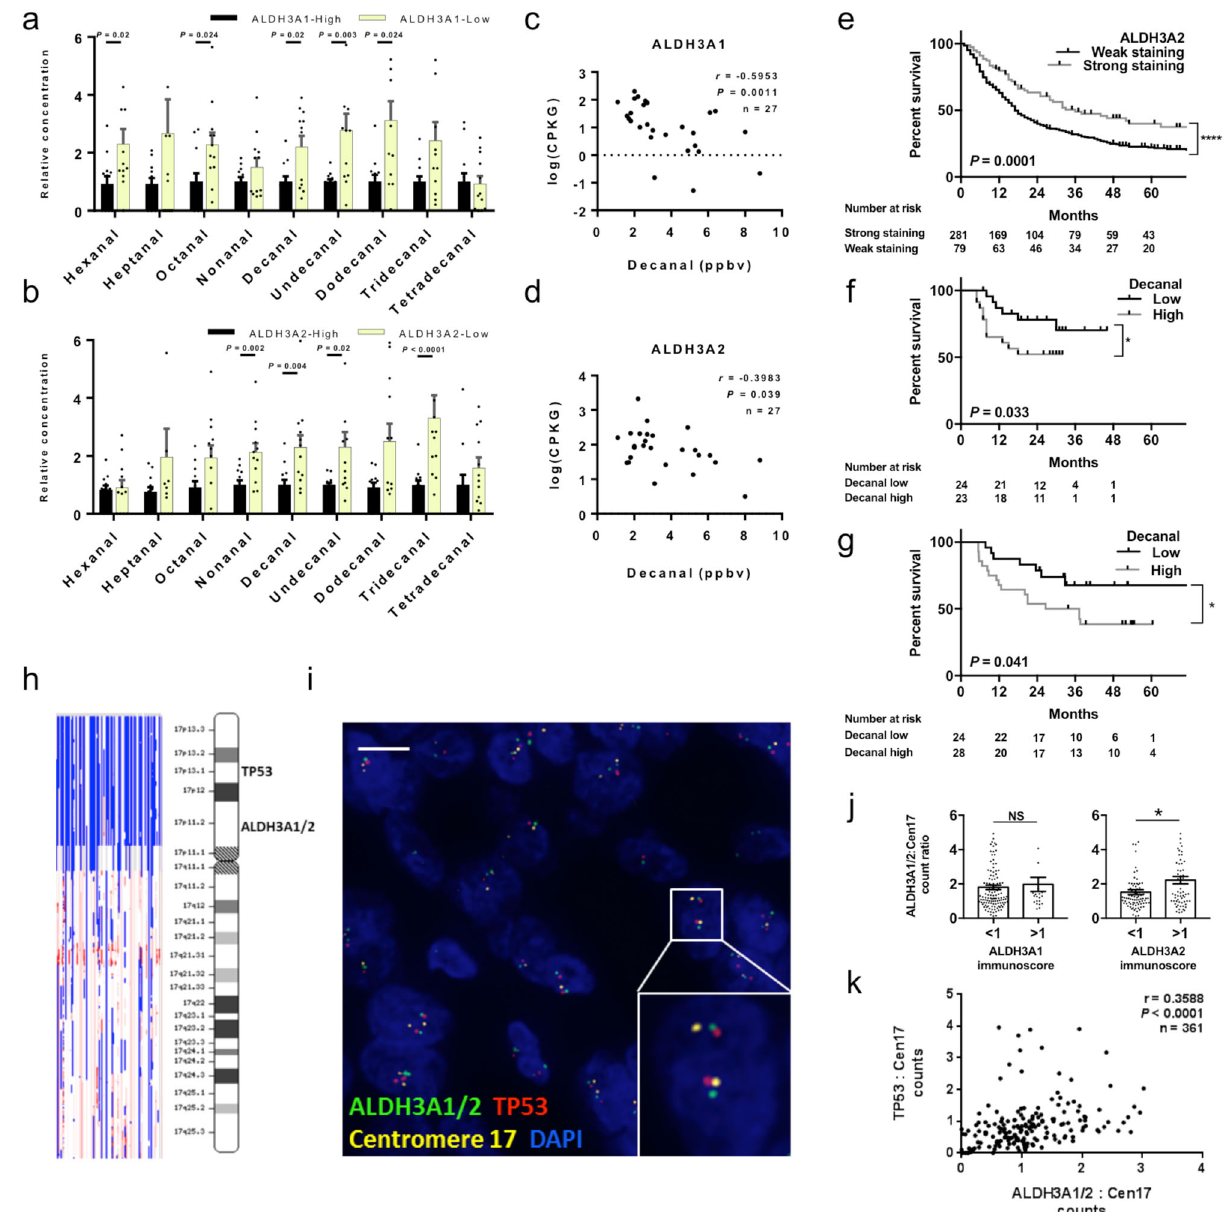
Fig. 5 ALDH3A2 loss connects decanal to prognosis and TP53 . a , b Relative aldehyde concentrations in tissue samples of esophageal adenocarcinoma (UPLC-MS/MS cohort) divided into ALDH3A1 ( a ) and ALDH3A2 ( b ) high or low tumors ( n = 24, two equal groups). c , d Correlations of ALDH3A1 ( c ) and ALDH3A2 ( d ) expression (CPKG, copies-per-thousand GAPDH values, n = 27) to paired exhaled decanal concentrations from Markar et al. 5 . e Overall survival in the multi-center immunohistochemistry cohort, strati fi ed by ALDH3A2 expression (immunoscore > 1 used as cut-off), log-rank test. Patients surviving <3 months from surgery were excluded (total included n = 329). f Overall survival for patients with esophageal adenocarcinoma in the previously published exhaled breath cohort 5 , dichotomized about the median ( n = 47). Patients surviving <3 months were excluded. g Overall survival for patients with esophageal adenocarcinoma in the present UPLC-MS/MS tissue aldehyde dataset, dichotomized about the median ( n = 52). Patients surviving <3 months were excluded. h GISTIC analysis of single-nucleotide polymorphism array data from The Cancer Genome Atlas ( n = 89). Blue indicates shallow deletion red indicates copy gain. i Representative fl uorescent in situ hybridization (FISH) image of EAC, bar indicates 25 μ m (false colors used). j ALDH3A1/ 2 FISH signal counts compared to ALDH3A1 and ALDH3A2 expression (cut-off immunoscore >1 used, n = 145, P = 0.0135 for ALDH3A2 ). k Correlation of TP53 FISH signals to ALDH3A1/2 FISH signals. One dot = one patient ( n = 134). Pearson ’ s test. Mean± SEM provided, two-tailed Mann – Whitney U -test used unless otherwise stated, * P < 0.05, ** P < 0.01, *** P < 0.001. Source data are provided in the Source Data fi